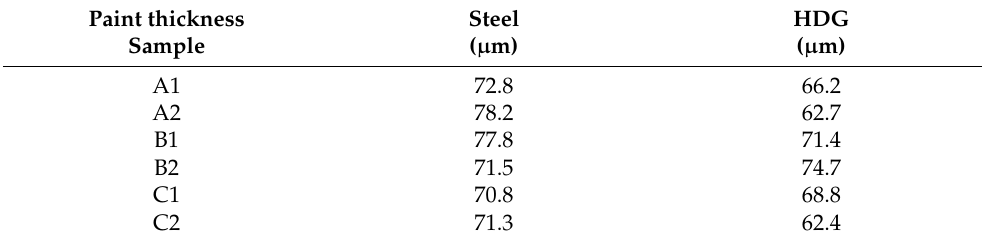
Table A2. A1 Coating thickness for samples aged in the prohesion test.